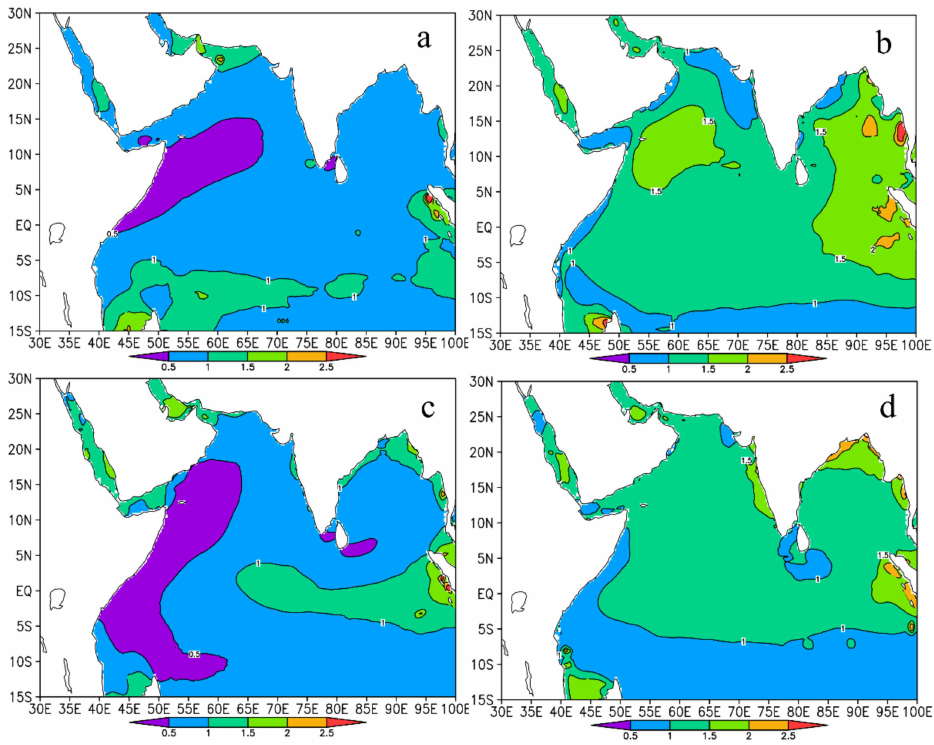
Figure 9. Coe ffi cient of variation of wind energy density in ( a ) winter, ( b ) spring, ( c ) summer, and ( d ) autumn in the NIO.